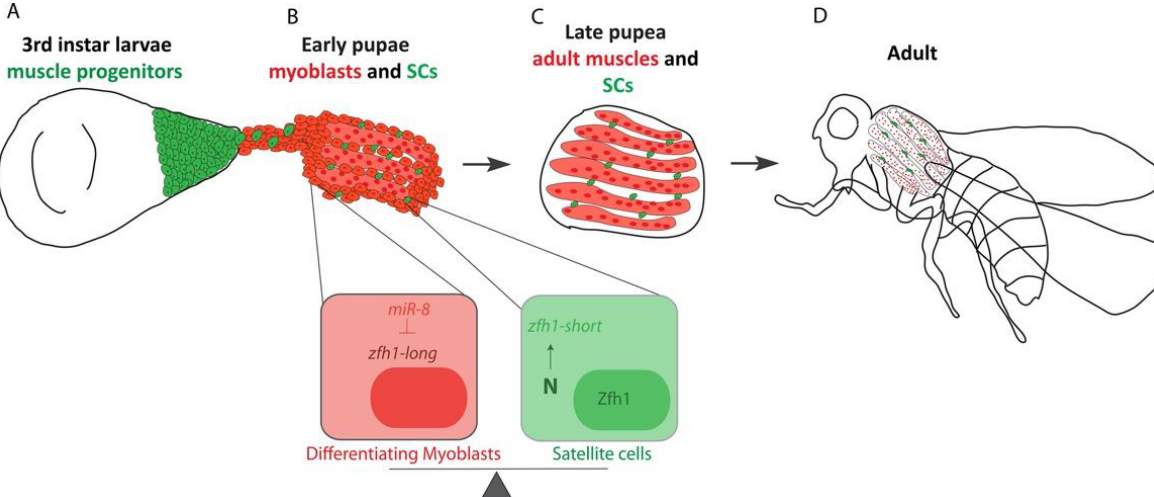
Figure 3. Schematic representation of Drosophila MuSC specification during the flight muscle formation (IFMs). ( A ) The adult muscle progenitors (AMPs) of the IFMs are associated with the wing imaginal discs. ( B ) During pupariation, the AMPs migrate toward the DLMs templates. Silencing of zfh1-long by miR-8 (red) facilitates the AMPs differentiation. zfh1-short (green) transcription is driven and maintained in MuSCs by Notch signaling. ( C ) At late pupal stages, the MuSCs and the IFMs formation is completed. Since zfh1-short is insensitive to miR-8 , Zfh1 protein is maintained in MuSCs, enabling them to persist in the adult ( D ).